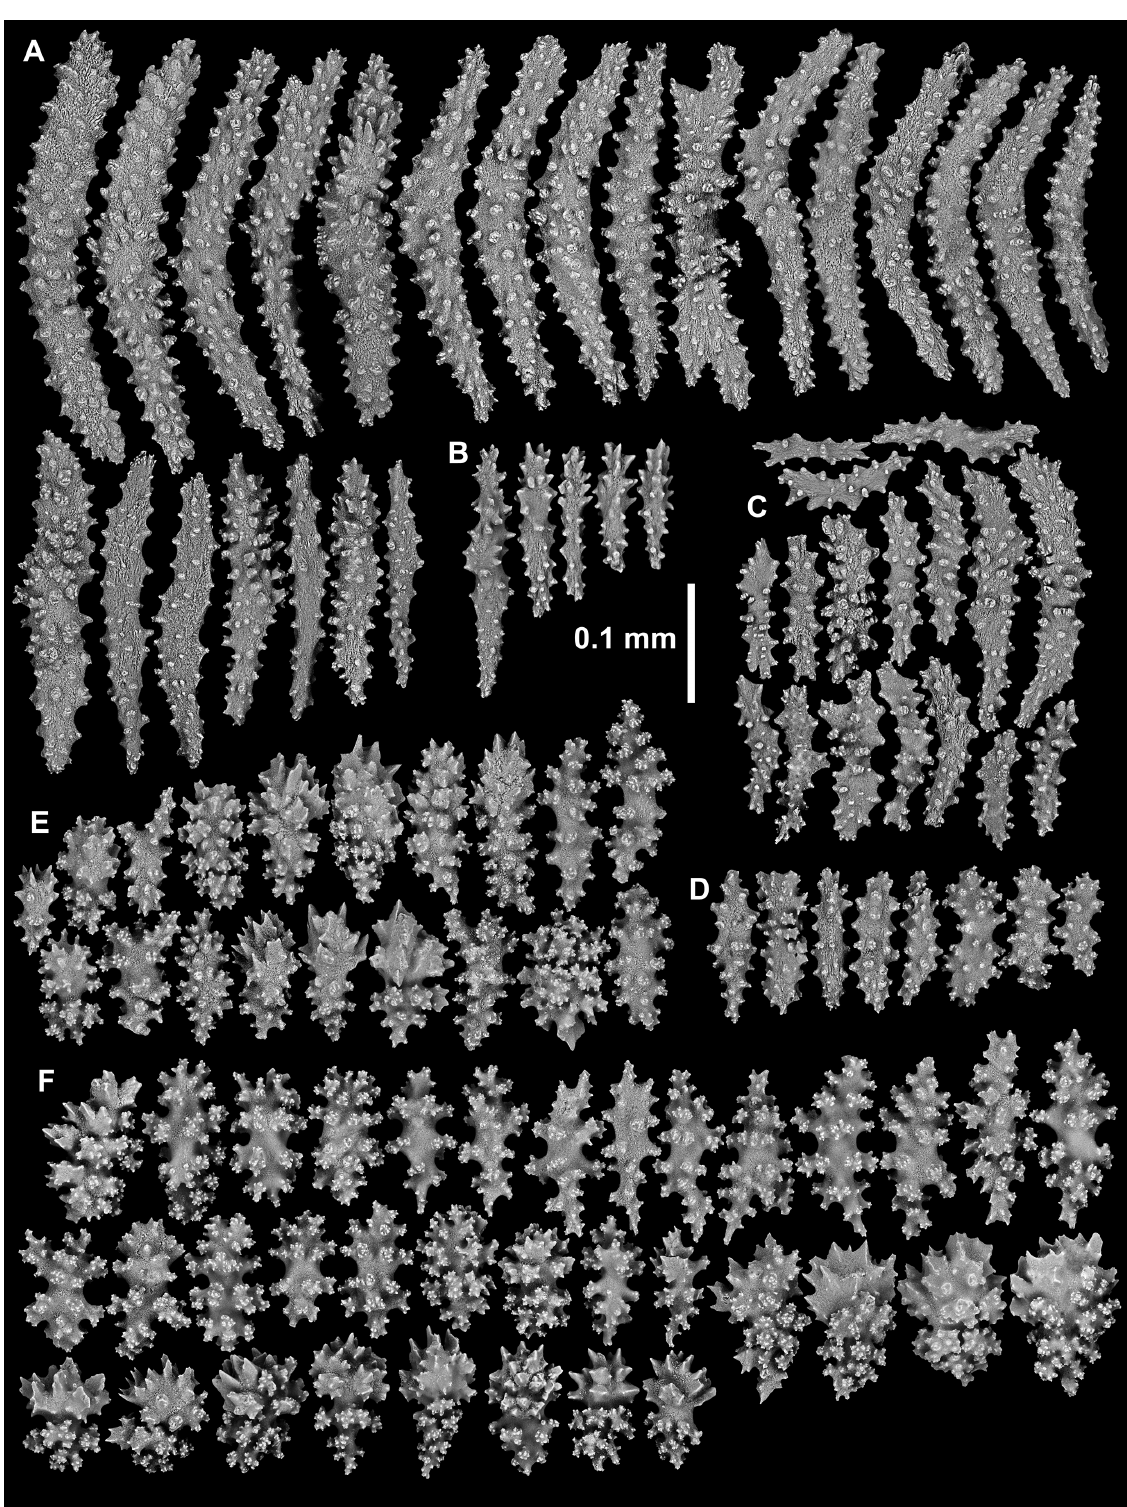
Fig. 25. Kotatea raekura gen. et sp. nov., holotype (NIWA 101537), SEMs of sclerites. A . Collaret and points. B . Distal points. C . Tentacles. D . Polyp neck. E . Polyp mound. F . Lobe